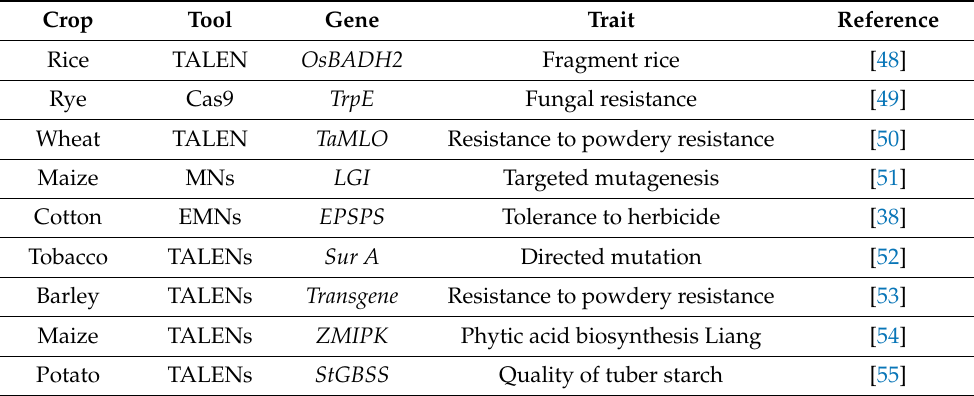
Table 1. Use of MNs, ZFNs, and TALENs for crops